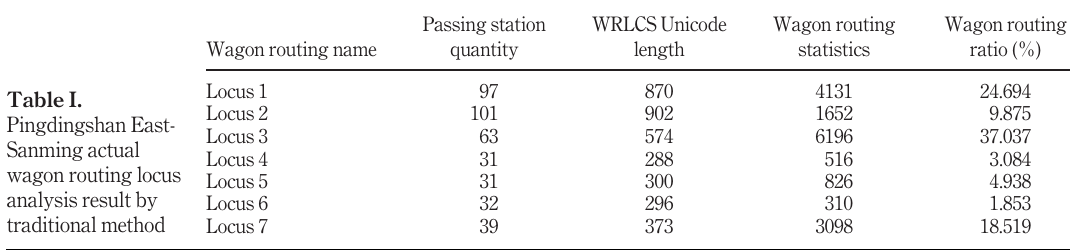
Table I. Pingdingshan East- Sanming actual wagon routing locus analysis result